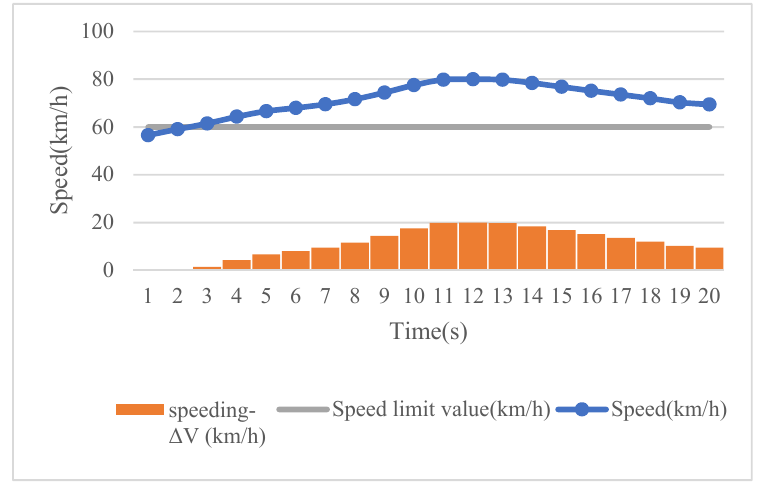
Figure 1. The magnitude of speeding—the area method.